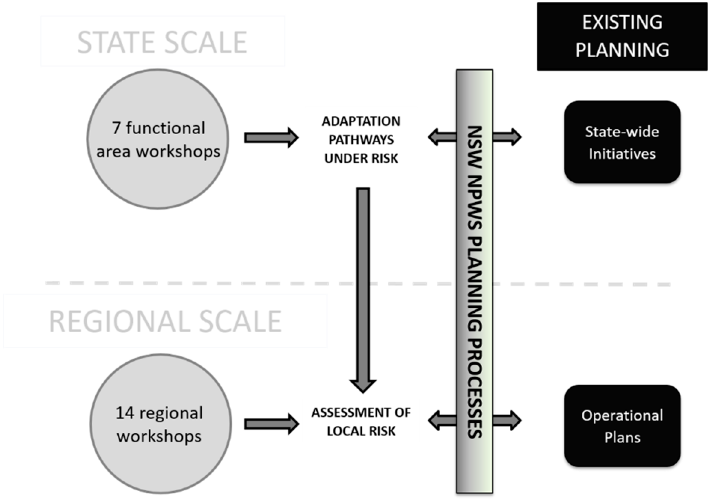
Figure 1. Process to elicit risk heuristics and adaptive pathways and its relationship to existing planning processes in the New South Wales National Parks and Wildlife Service (NPWS).